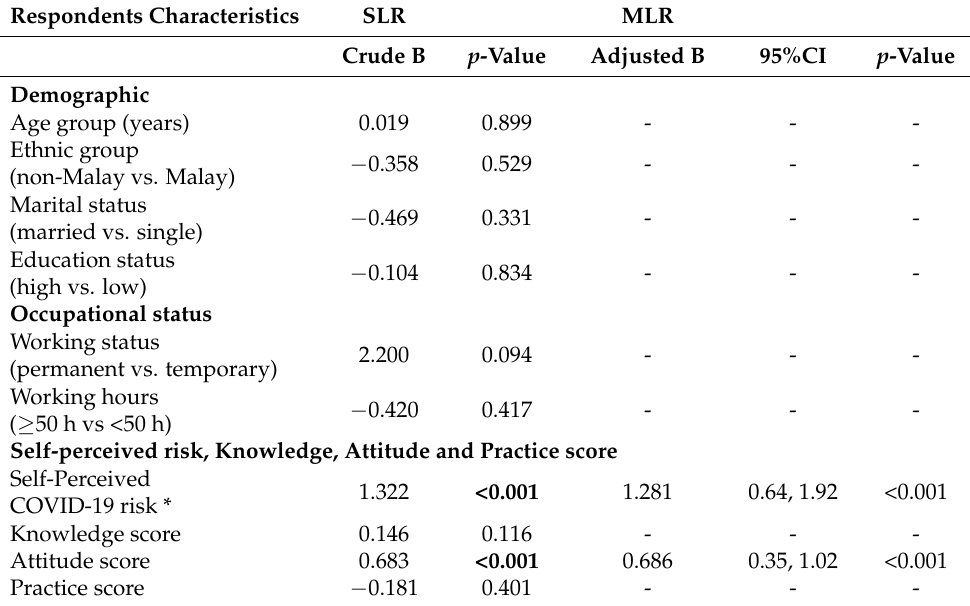
Table 4. Predictors of HAI score using simple and multiple linear regression (N =